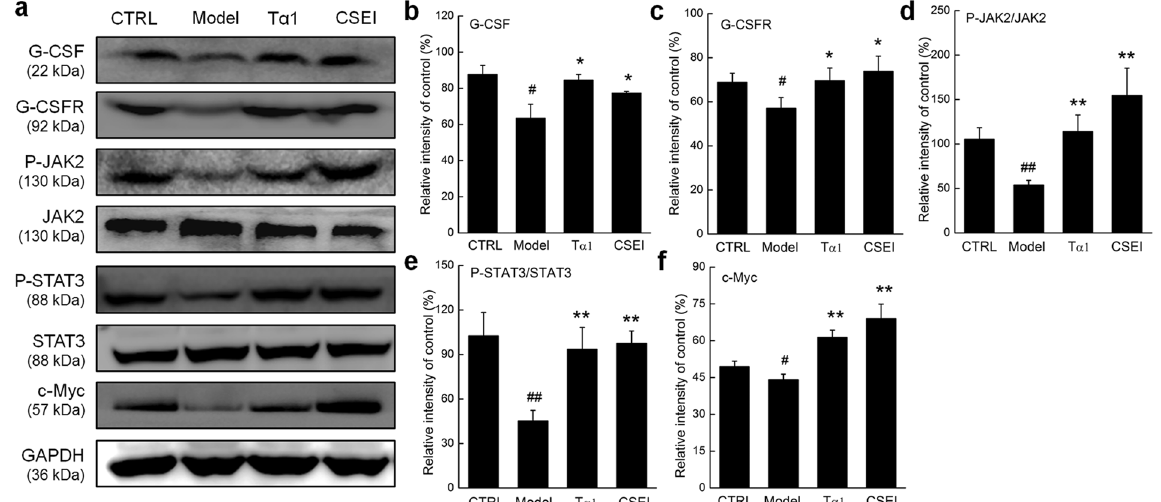
Figure 6. G-CSF-mediated JAK2/STAT3 signaling pathway is, at least, partially involved in the protective effect of CSEI on mice with CTX-induced hematopoietic injury. ( a ) CSEI at a dose of 4.5 mg/kg enhanced the levels of G-CSF, G-CSFR, P-JAK2, P-STAT3 and c-Myc in spleen of CTX-injected mice after a 21-day treatment. The quantitative data of the G-CSF ( b ), G-CSFR ( c ), P-JAK2 ( d ) P-STAT3 ( e ) and c-Myc ( f ) levels were normalized by the corresponding GAPDH and related total protein expressions, and expressed as the percentage of the corresponding relative intensity of the control. Full-length blots are presented in Supplementary Fig. S6a. The data are shown as the means ± S.E.M. (n = 10). # P < 0.05 and ## P < 0.01 versus the control group, * P < 0.05 and ** P < 0.01 versus the model group.